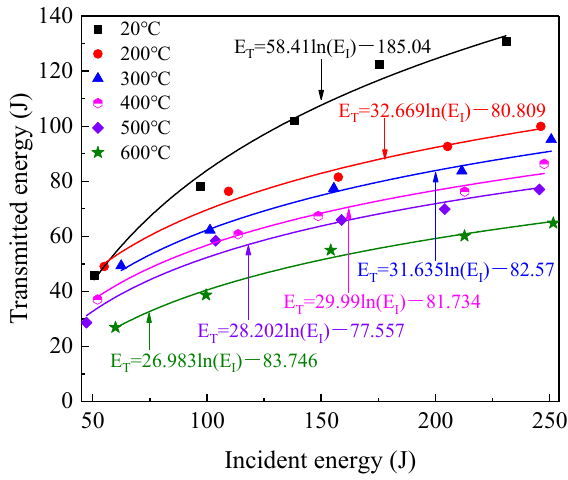
Figure 13. Relationship between transmitted and incident energy.